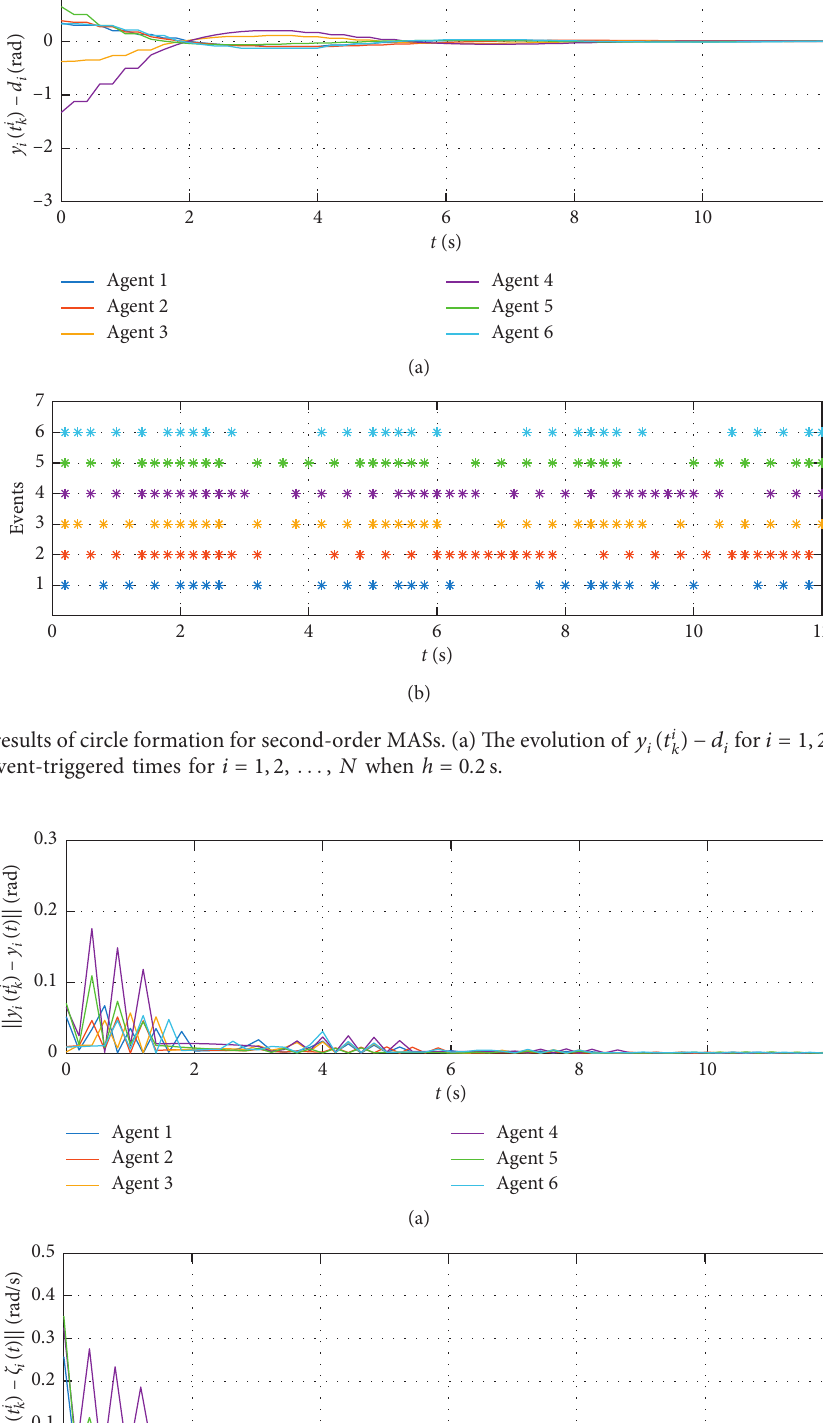
( t i ) − y ( t )‖ for i � 1 , 2 , ... , N when i i k